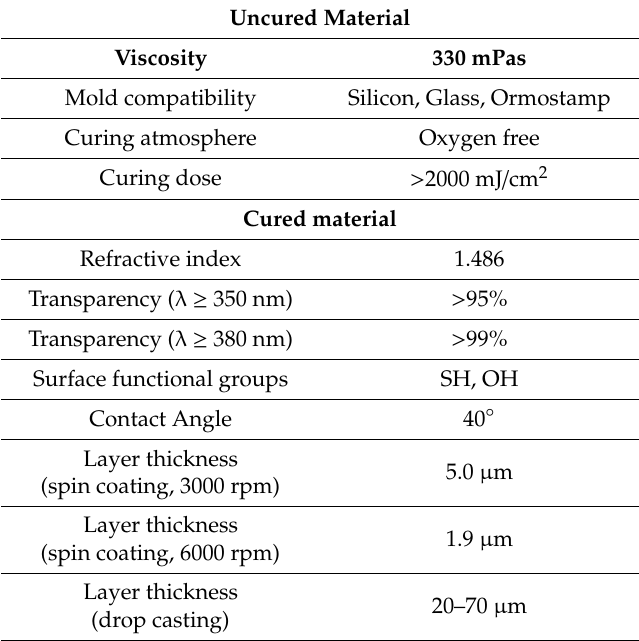
Table 2. General properties of the polymer before and after